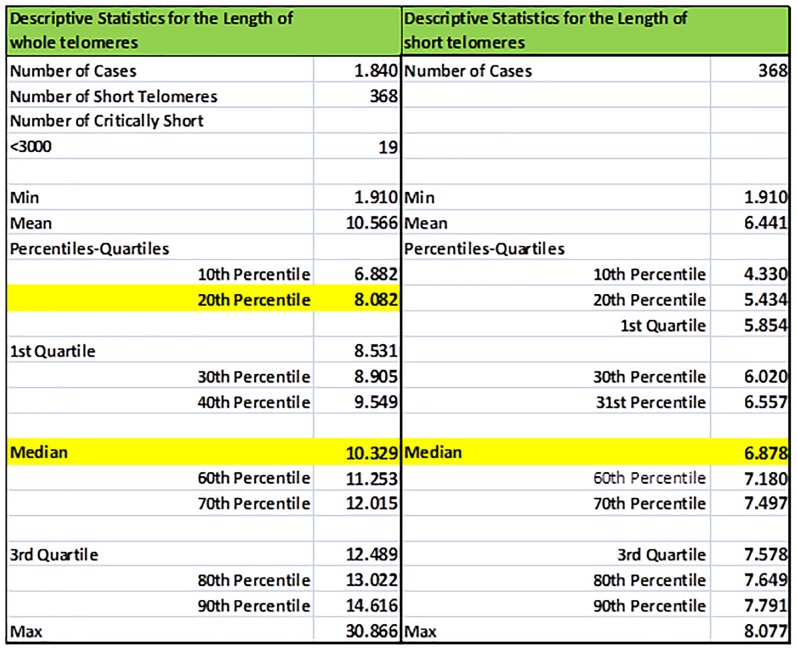
Sample basic descriptive statistics (percentiles, quartiles, min/max, mean) of the whole (TL) and short (TLS) telomeres (<20th percentile) of a selected individual. In our example statistics of the individual re-coded as Sample005 is shown.